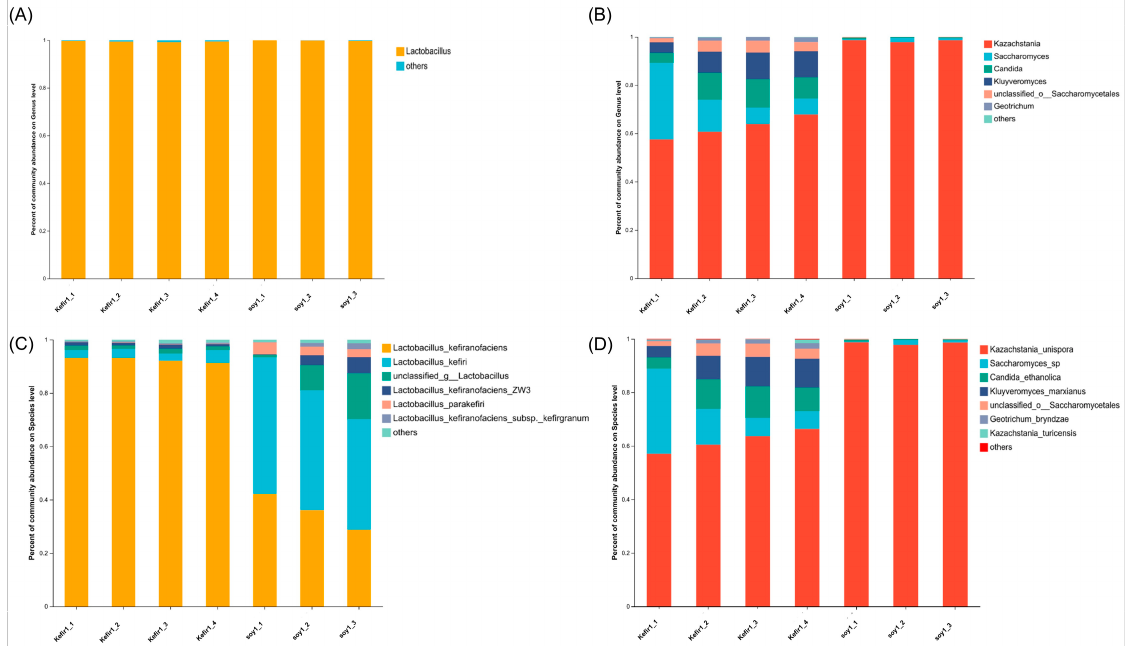
Figure 5. Relative abundance at the genus (( A )—bacteria, ( B )—fungi) and species (( C )—bacteria, ( D )—fungi) levels in kefir grains and soybean kefir